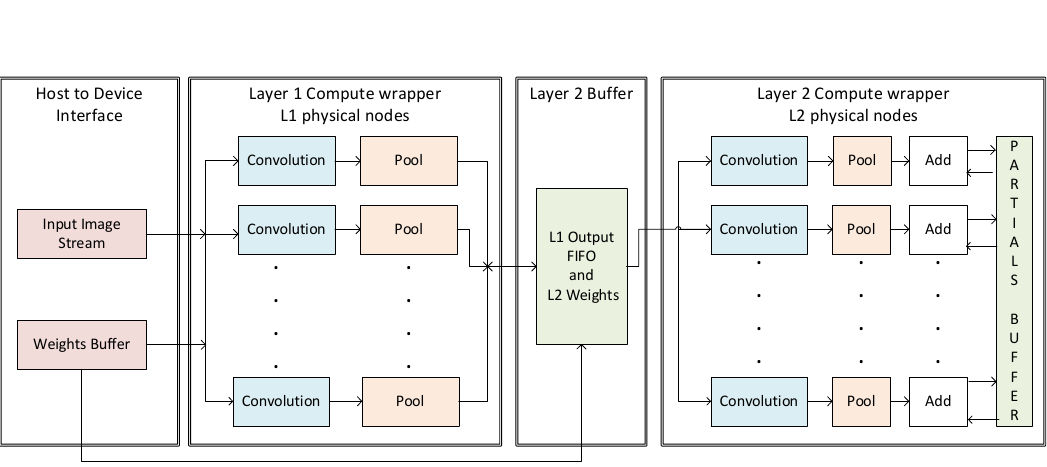
Figure 5. High Level Hardware Architecture for CNN Acceleration